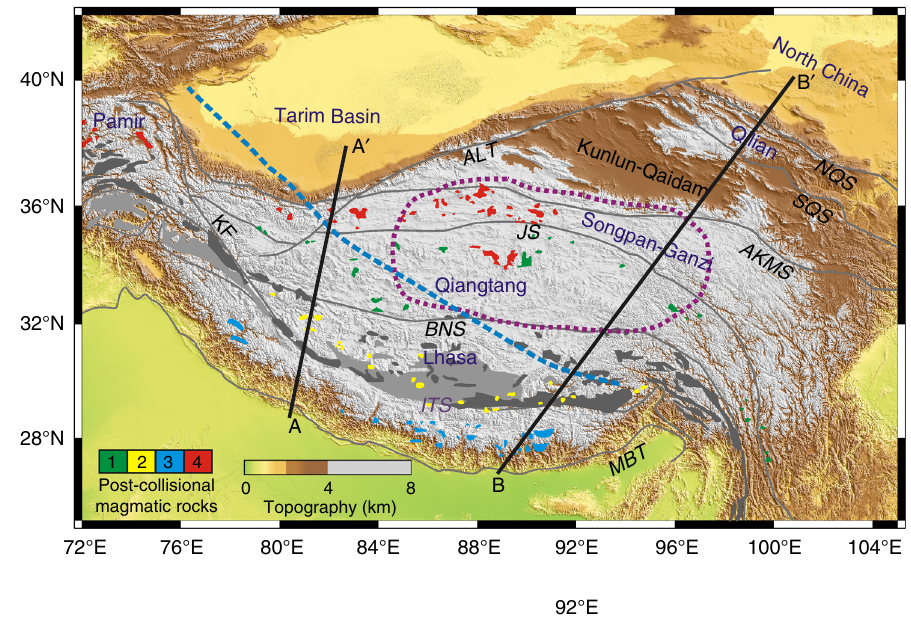
Fig. 1 Tectonic framework of the Tibetan plateau. Four main suites of post-collisional magmatic rocks are shown with different color: 1 (green) = Eocene to Oligocene potassic rocks; 2 (yellow) = Late Oligocene to Mid-Miocene rocks; 3 (blue) = Himalayan leucogranites; 4 (red) = Mid-Miocene to Quaternary potassic rocks 21,49,65 The dark and light gray areas in southern Tibet denote Gangdese granitoids and Paleogene Linzizong volcanic rocks, respectively 49 . The thick purple dashed line delineates the zone of poor Sn propagation 5,12 – 14 . The thick blue dashed line represents the northern boundary of the Indian lithosphere at 200km depth 5 . Pro fi les AA ′ and BB ′ are locations of schematic cross-sections illustrated in Fig. 6, representing the lithospheric structure of the western and central – eastern Himalayan – Tibetan orogen. Gray lines mark the major fault traces and suture zones. MBT Main Boundary Thrust, ITS Indus – Tsangpo suture, BNS Bangong – Nujiang suture, JS Jinsha suture, AKMS Anyimaqen – Kunlun – Muztagh suture, SQS South Qilian suture, NQS North Qilian suture, KF Karakoram fault, ALT Altyn Tagh fault. The Generic Mapping Tools 66 was used to create the topographic map, with the topography data from ETOPO1 Global Relief Model (https://www.ngdc.noaa.gov/mgg/global/global.html). In addition, the software CorelDRAW was further used to draw all the other elements in the fi